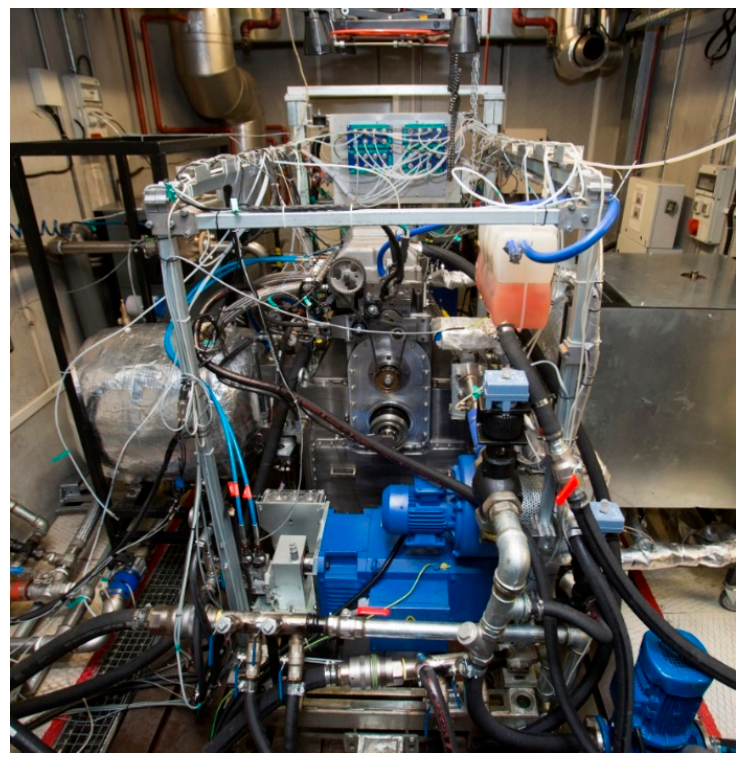
Figure 1. Single-cylinder research engine dyno installation.